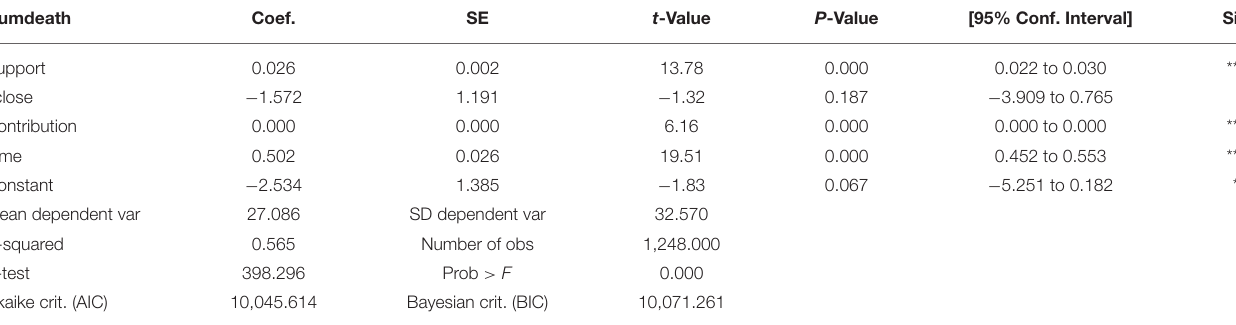
TABLE 6 | The regression estimation results for the two-way fixed effects model of the influence of aid intensity on the cumulative number of deaths. Cumdeath